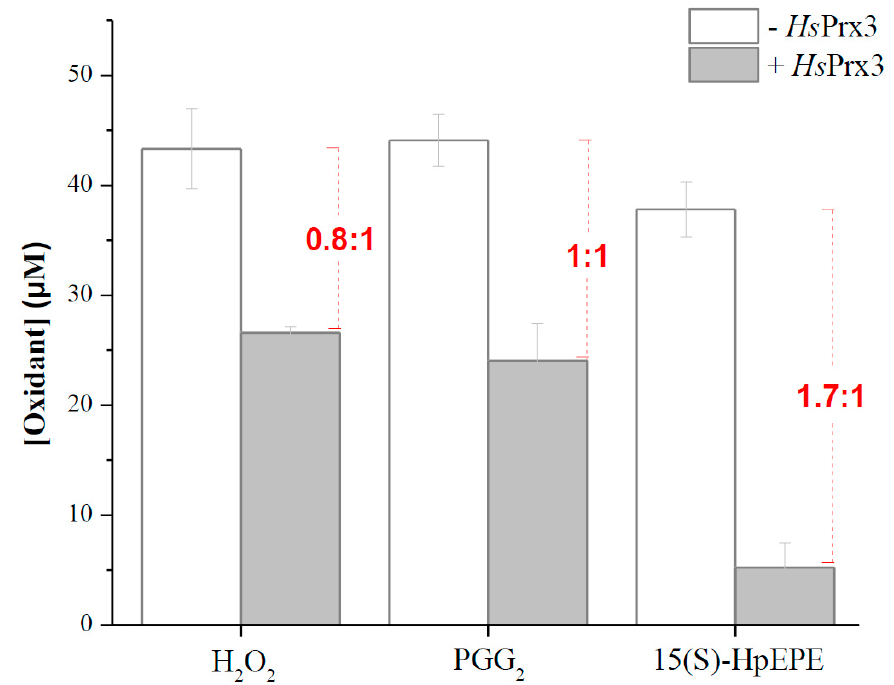
Figure 3. Stoichiometry of hydroperoxide consumption by Hs Prx3. 15(S)-HpEPE and PGG 2 con- sumption by Hs Prx3. H 2 O 2 , PGG 2 and 15(S)-HpEPE (left to right) decay in sodium phosphate buffer 50 mM (pH 7.8, 25 °C) in the absence (white bars) or 30 s after the addition of 20 µM reduced Hs Prx3 (grey bars). Numbers in red represent the stoichiometry of hydroperoxide consumption.